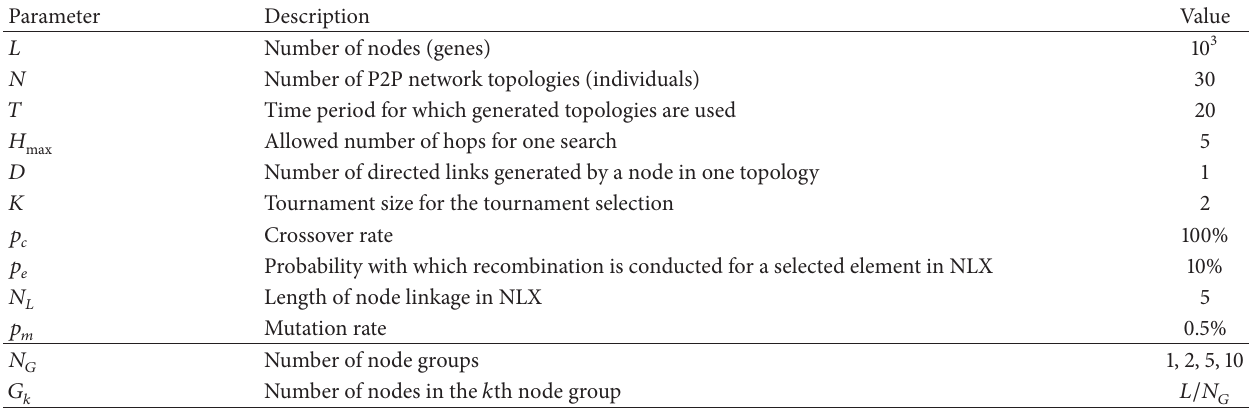
Figure 7: Timing to reconstruct the network topologies by the sequential topology evaluation method. The number of node groups, 𝑁 𝐺 , is three. Table 1: Parameters values of P-EP2P used in the